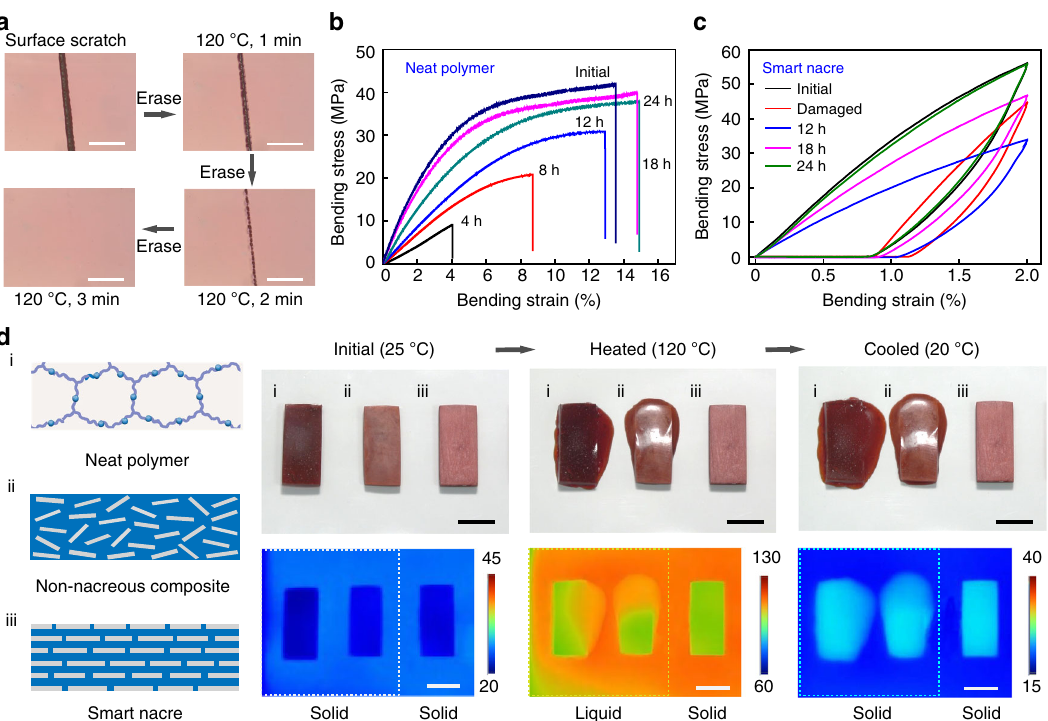
Fig. 2 Self-healing behavior of the smart nacre. a Sequential optical images recording the erasure of a surface scratch on the neat polymer. Stress – strain curves of the remolded neat polymer ( b ) and self-healed smart nacre ( c ). Note that while the composite was damaged by fatigue test, the healing property of the neat polymer was investigated by cutting a bulk sample into two halves and remolding them via the reversible network formation. d Comparisons between the neat Diels – Alder polymer, a non-nacreous composite with random fi llers, and the smart nacre with aligned fi llers: thermal stability illustrated via optical and infrared images. Scale bar in a is 100 μ m and in d is 1